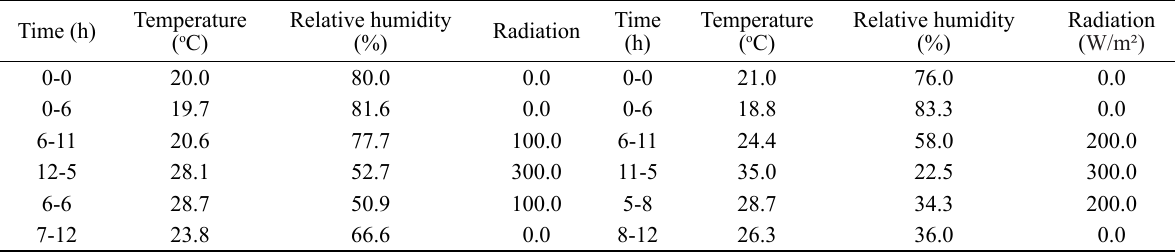
Table 1 . Environments compared under control